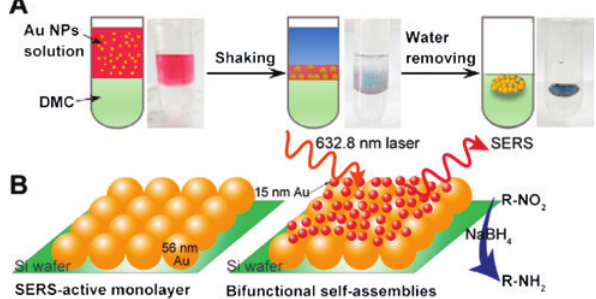
Figure 5: Schematic of the construction of hierarchically struc- tured bifunctional Au nanoarrays via interfacial self-assembly for quantitative real-time SERS monitoring of the catalytic process. (A) The self-assembly process; (B) the SERS monitoring procedure for catalytic reaction. Reproduced from Zhang et al. Anal. Chem. 2015b , 87 , 8702–8708. Copyright © 2014 American Chemical